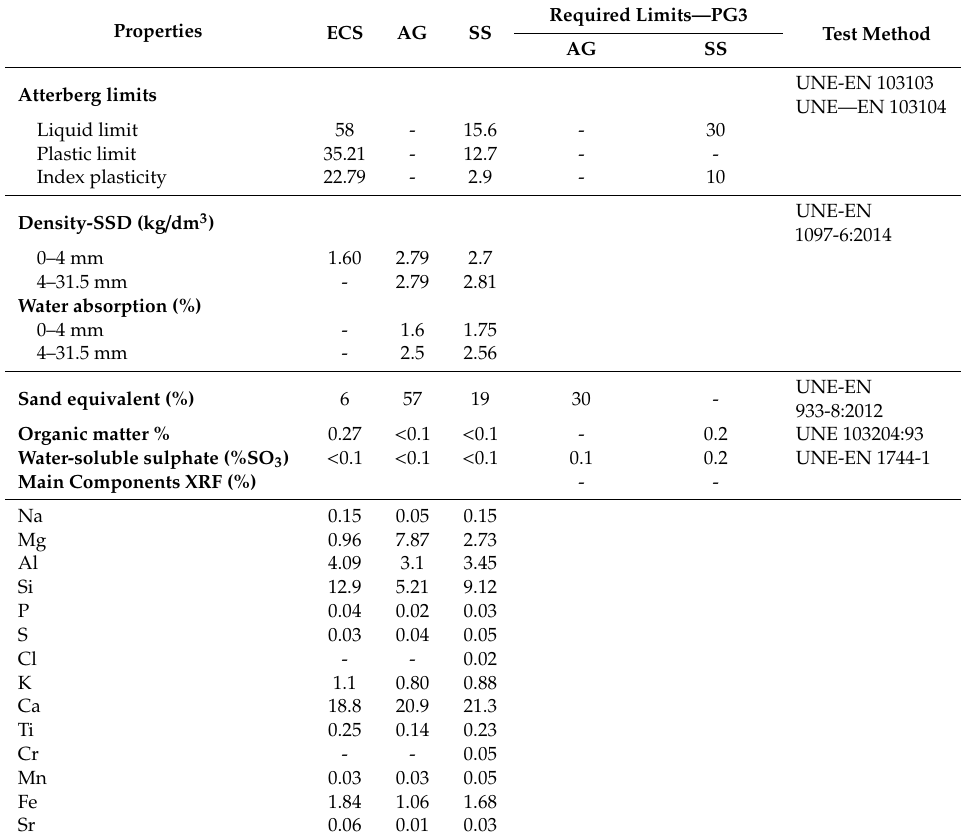
Table 1. Physical and chemical properties of Expansive clay soil (ECS), Artificial gravel (AG) and Selected soil